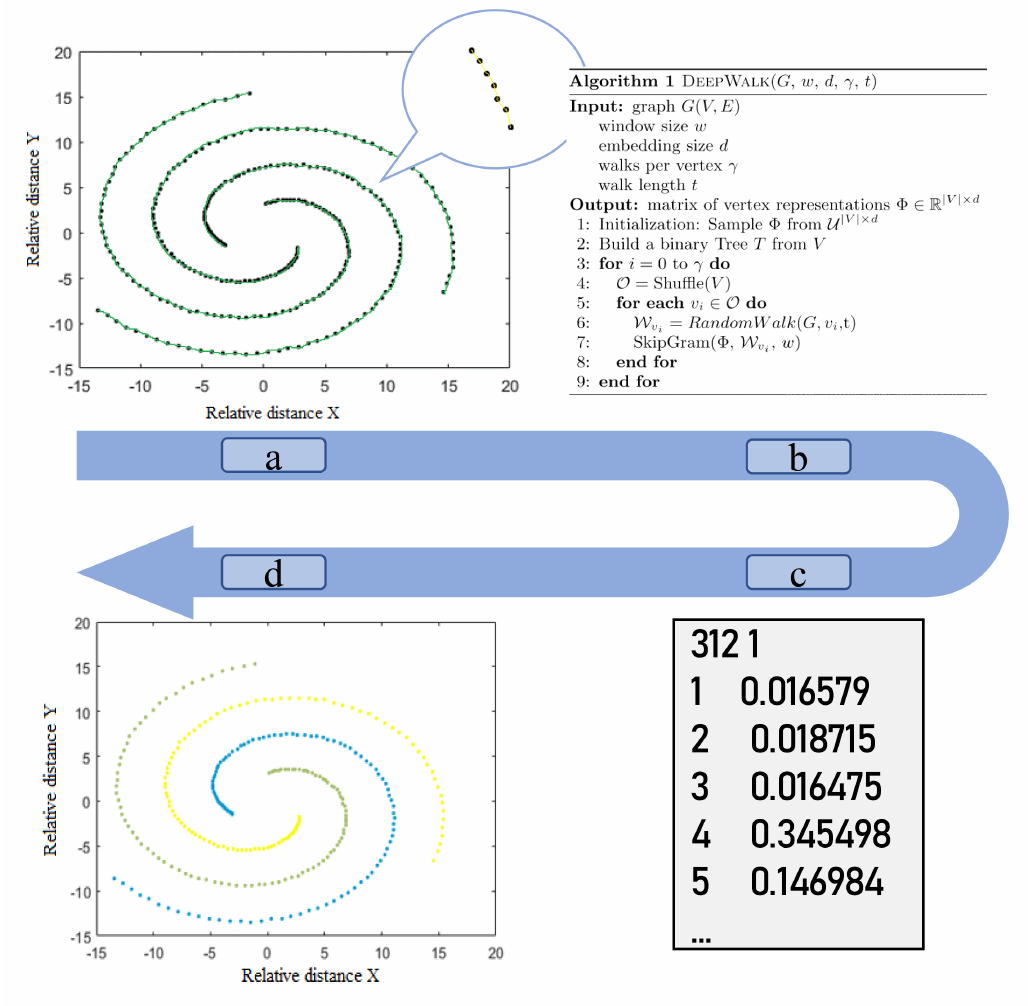
Figure 1. We first set the distance threshold to get the graph 1, ( a ) then input the topology into DeepWalk network 1. ( b ) The topological characteristics of each point of the data are obtained ( c ), which show the one-dimensional characteristics of 312 points. Then, the feature meaning correspondence is combined with the original data, and the topological feature is used as the weight to cluster the data to get 1. ( d